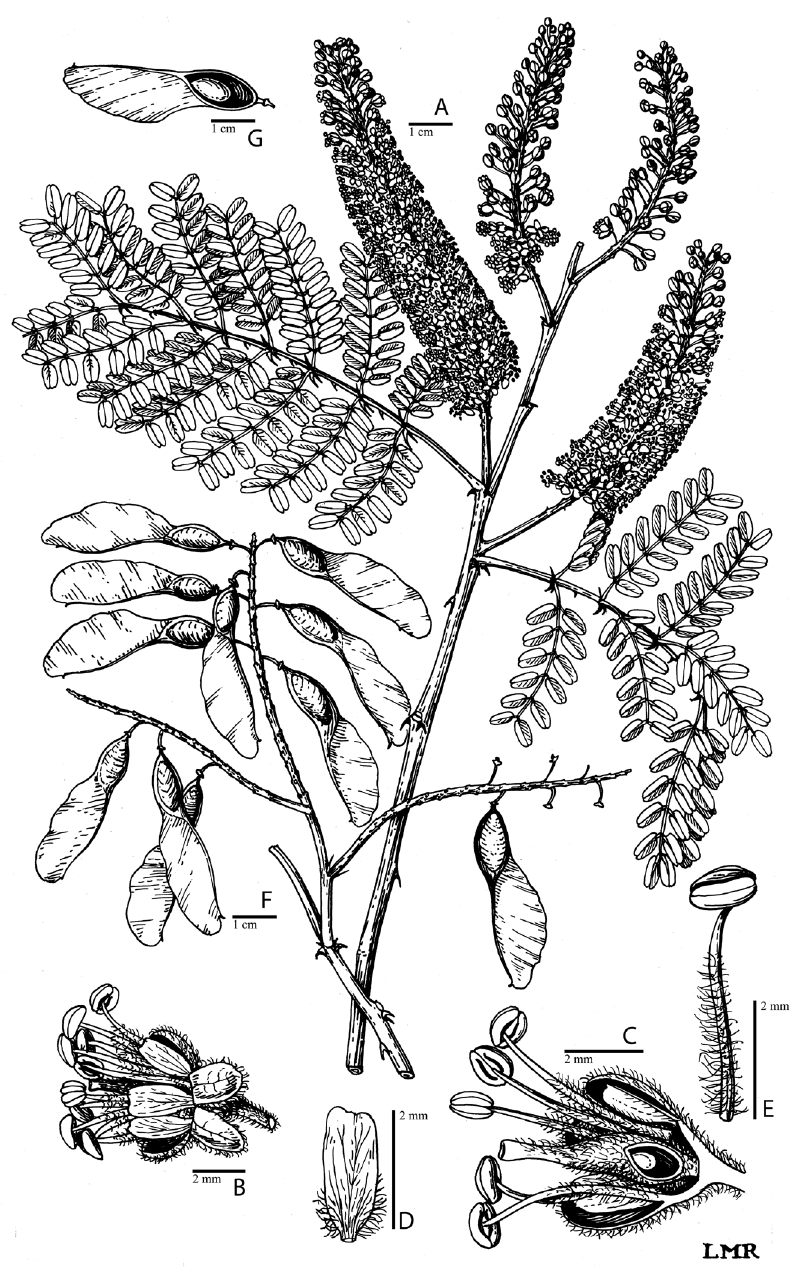
Figure 23. Pterolobium stellatum (Forssk.) Brenan . A part of flowering branch B flower C longitudinal section of flower D petal E stamen F infructescence with mature fruits G samara with part cut away to reveal seed. A–E from Richards 11275 F from Eggeling 3400 G from Sandwith 25. Drawn by L. M. Ripley, originally published in Flora of Tropical East Africa, Leguminosae subfamily Caesalpinioideae , page 41, fig. 7